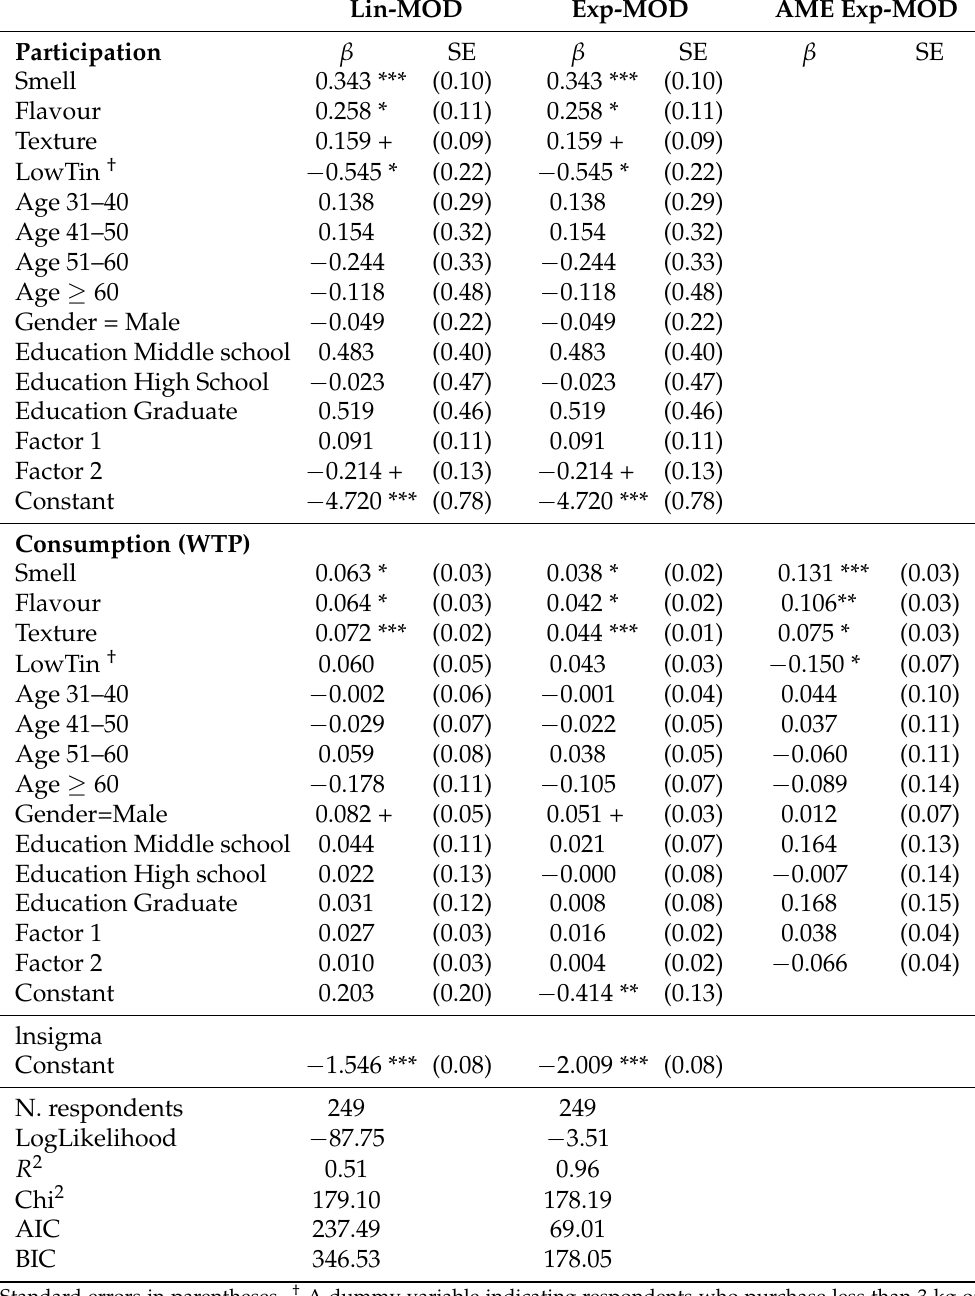
Table 5. Double-hurdle model